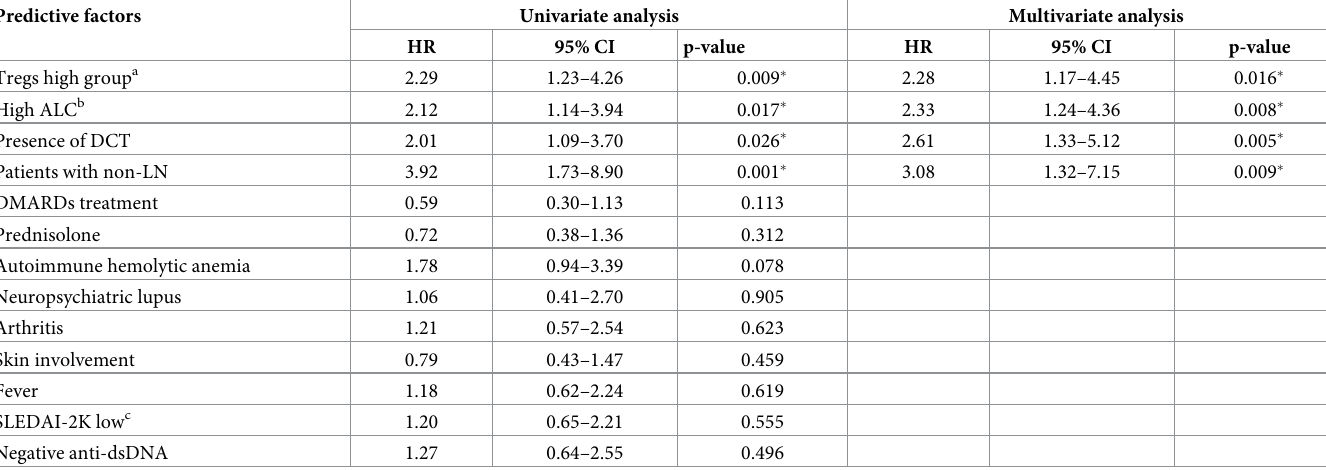
Table 4. Predictors of remission on therapy in the juvenile-onset systemic lupus erythematosus patients. Predictive